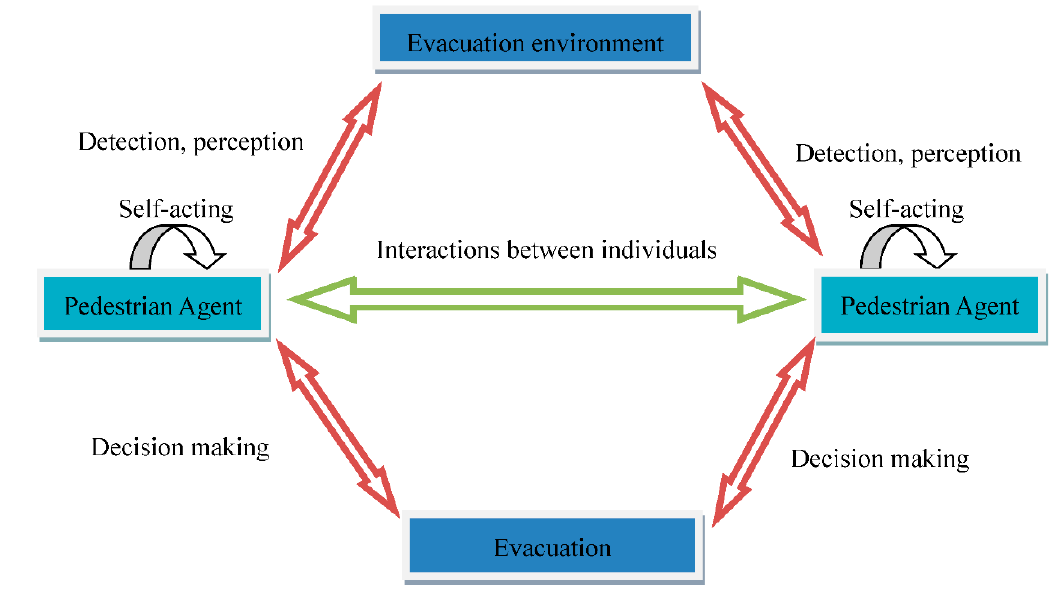
Figure 1. Theoretical model of the AEM.